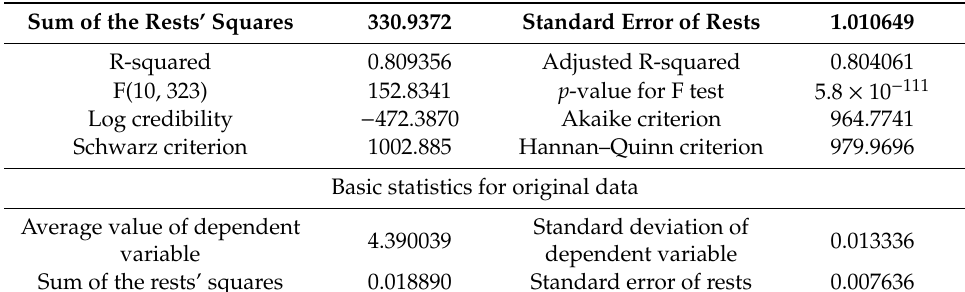
Table 9. Model 2 fitting measures (dependent variable LE(f) = 0).